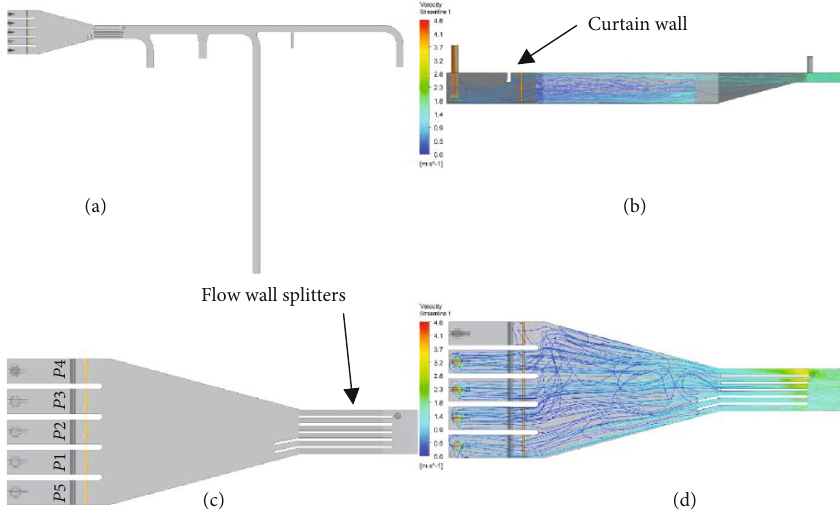
Figure 1: Pump intake — geometry and